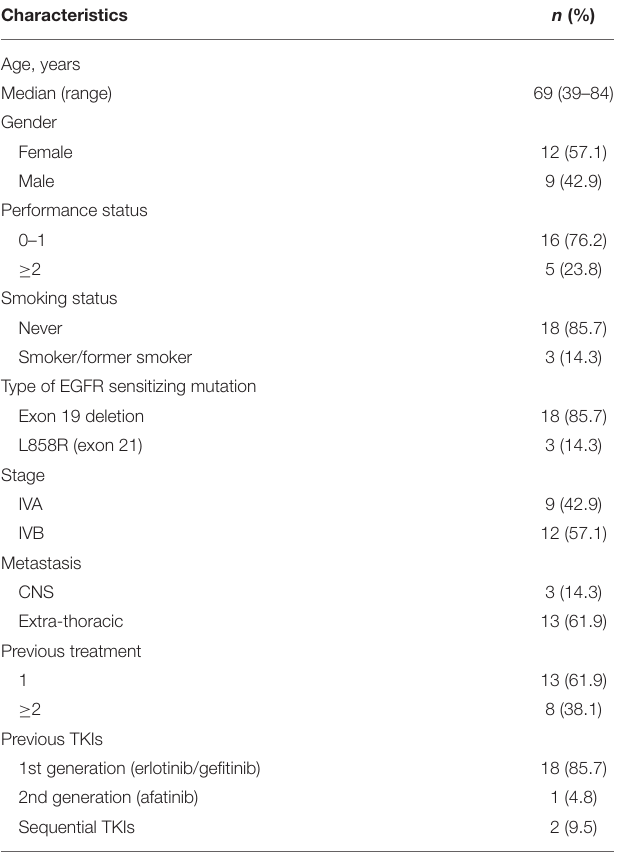
TABLE 1 | Baseline patients’ characteristics.